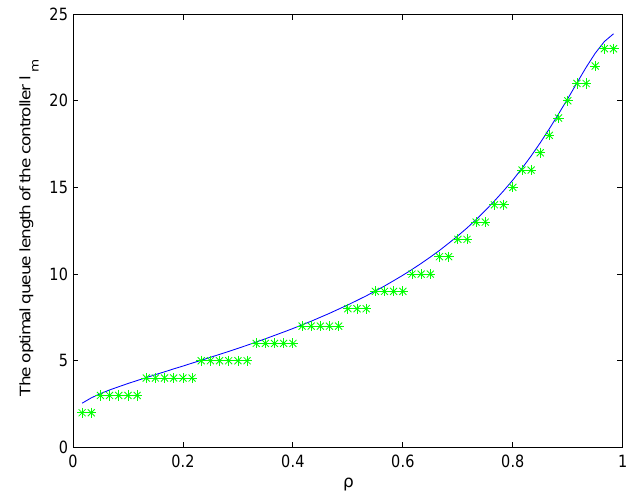
Figure 3. The optimal queue length of the controller for the different arrival